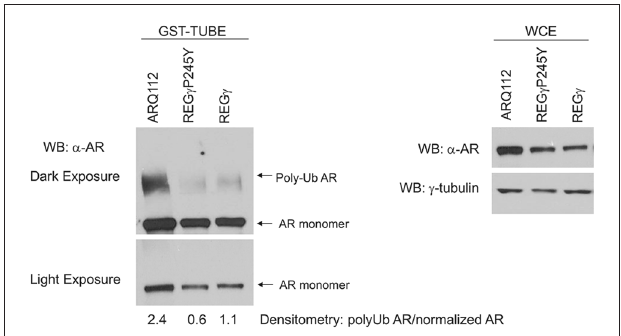
FIGURE 6 | Overexpression of REG γ and REG γ P245Y decreases the polyubiquitination state of ARQ112. PC12 ARQ112 cells were induced with Dox for 48 h, and then treated for an additional 12 h with Dox, DHT and epoxomycin. Cells were harvested in tandem ubiquitin binding entity (TUBE) cell lysis buffer and treated with GST-TUBE2. TUBE assay protocol was carried out and the eluate was evaluated by Western analysis using anti-AR antibody AR(441) to detect polyubiquitinated ARQ112 (left). Densitometry was performed and the ratio of polyubiquitinated AR to WCE normalized AR monomer (right) was calculated.